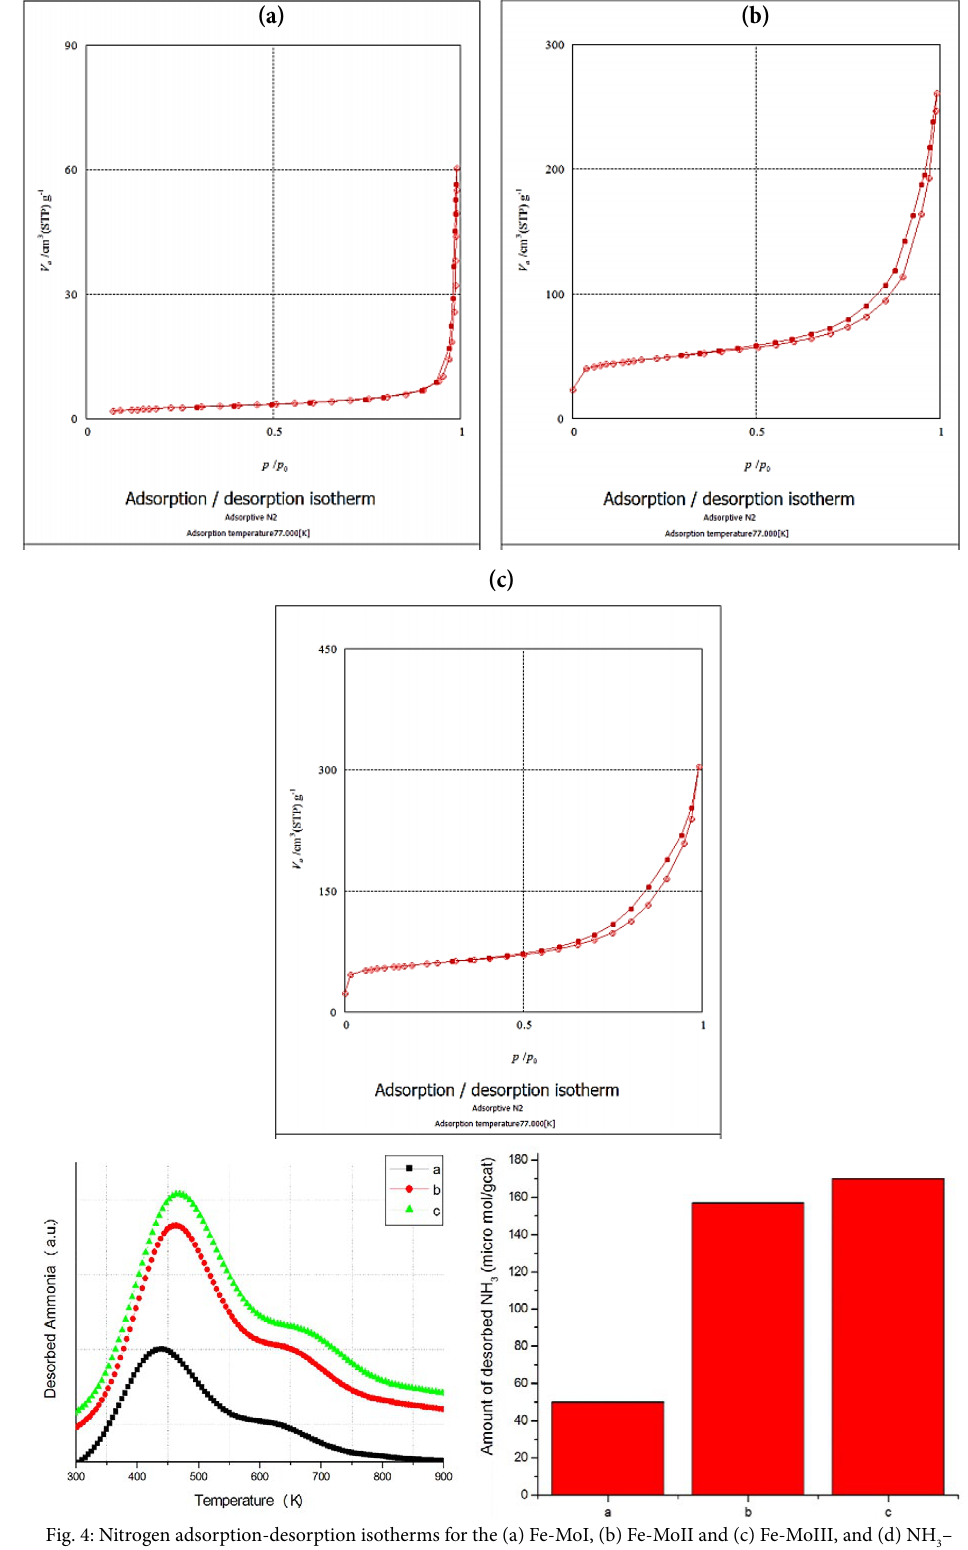
Fig. 4: Nitrogen adsorption-desorption isotherms for the (a) Fe-MoI, (b) Fe-MoII and (c) Fe-MoIII, and (d) NH TPD profiles of (a) Fe-MoI, (b) Fe-MoII, (c) Fe-MoIII accomplished by mount